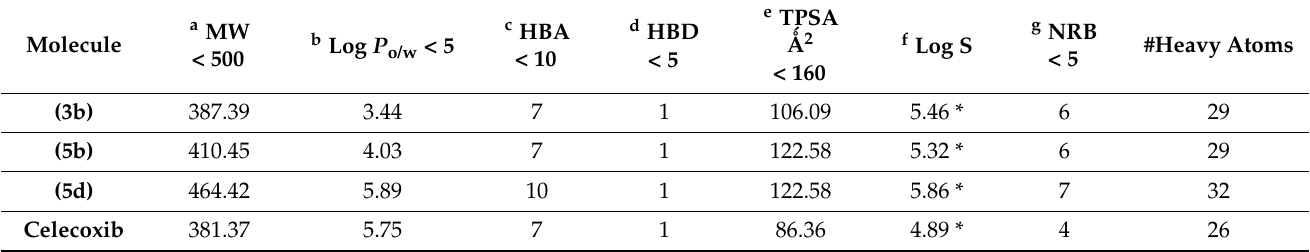
Table 7. In silico physicochemical properties for compounds 3b , 5b , and 5d , as well as Celecoxib.